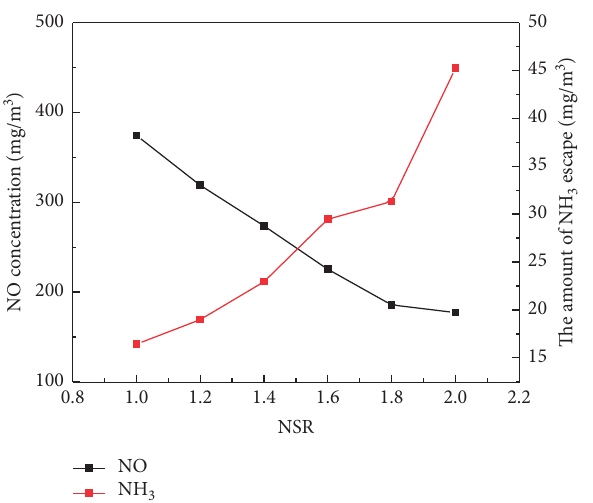
Figure 9: Variation of NO concentration and NH centration at the outlet of the decomposing furnace with NSR.